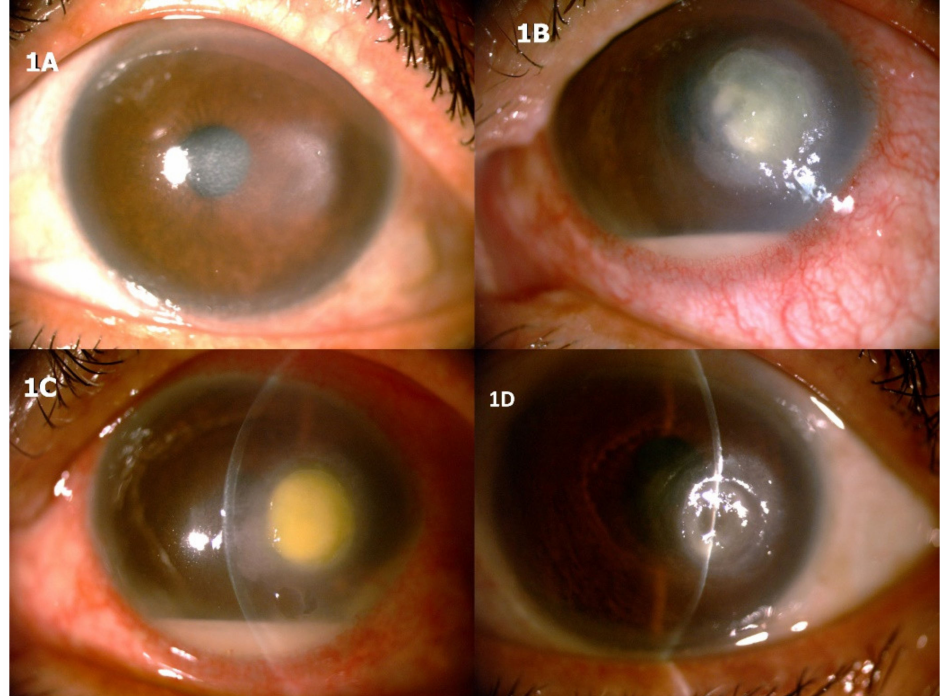
Figure 1. The first patient presented with contact lens-related infectious keratitis. ( A ) After obtaining a positive microscopic examination with identification of hyphae, topical steroids were discontinued immediately and antifungal therapy was started. In the following days, keratitis became more severe ( B , C ) and the fungal pathogen was identified as Beauveria bassiana and ultimately resolved ( D ) by modifying antifungal